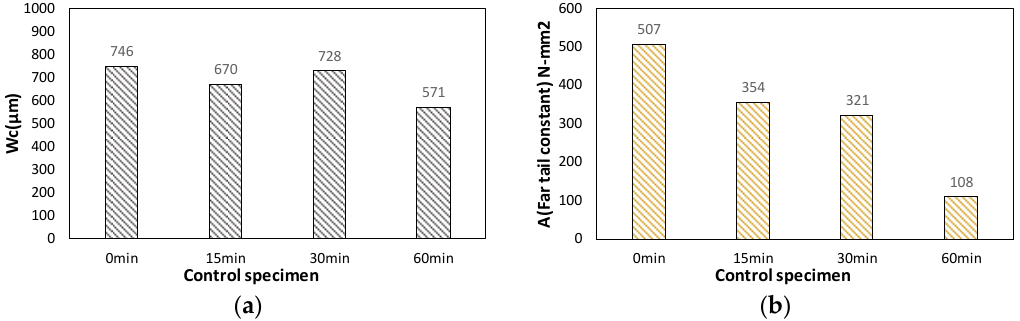
Figure 10. ( a ) Obtained results for far tail constant, A ; and ( b ) critical crack opening displacement, Wc .